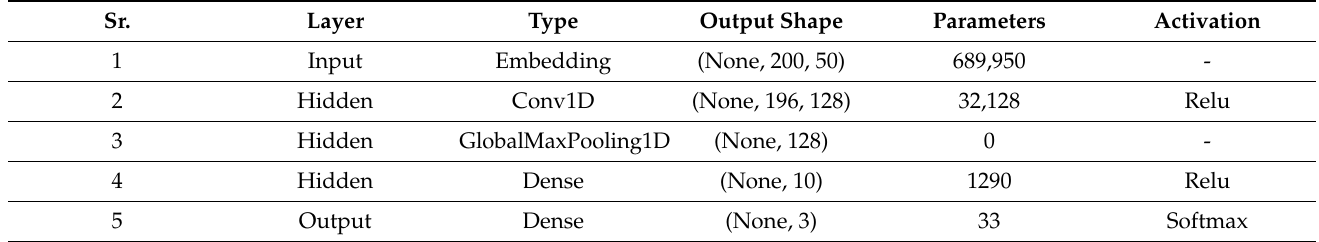
Table 9. Model summary of the fine-tuned convolutional neural network.